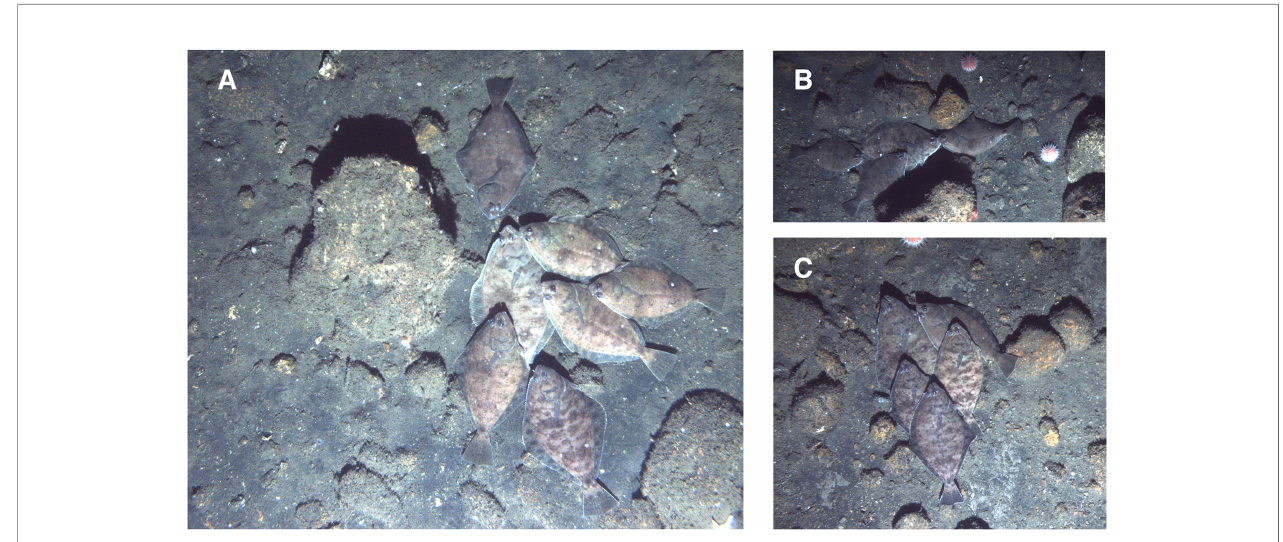
FIGURE 2 | (A – C) Images taken by the AUV of petrale sole gathered together in